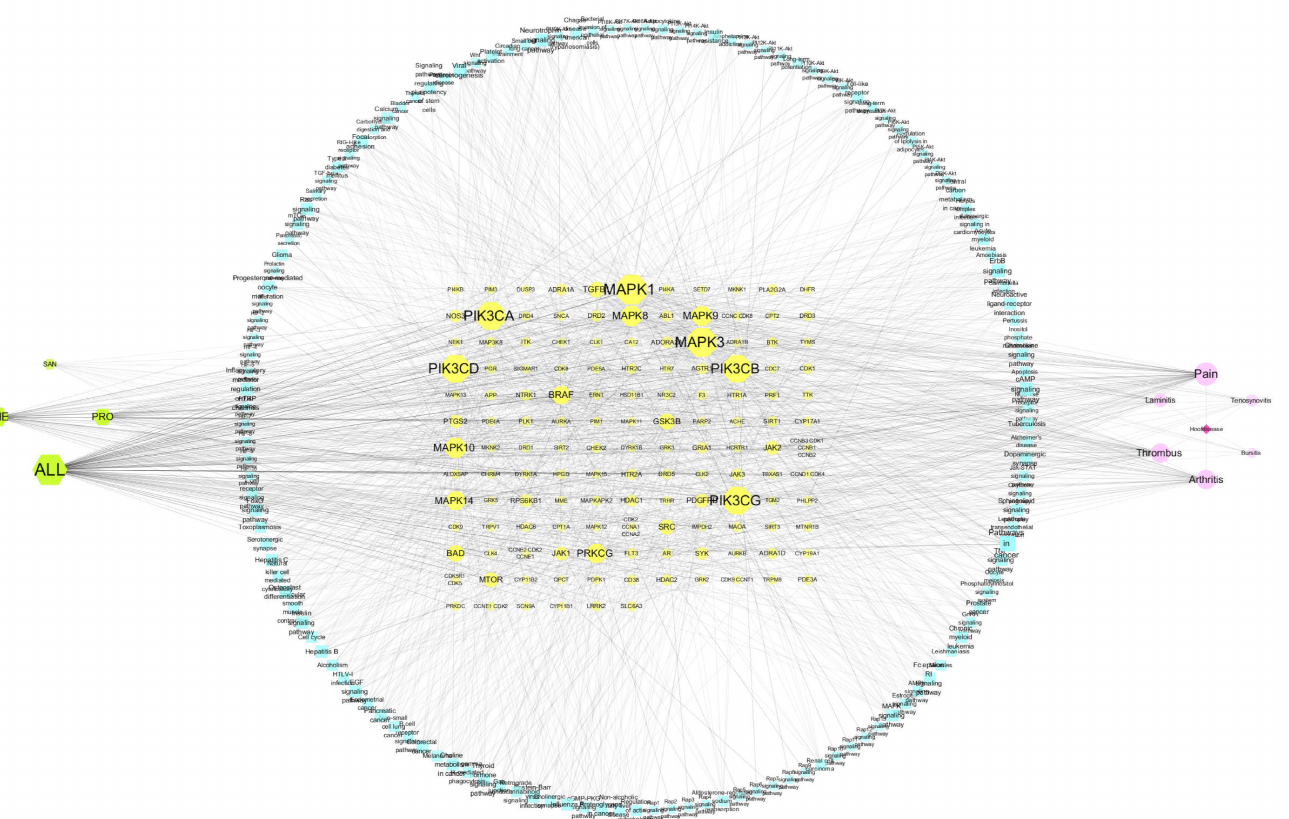
Figure 9. Compound − target − pathway − disease interaction visualization network.